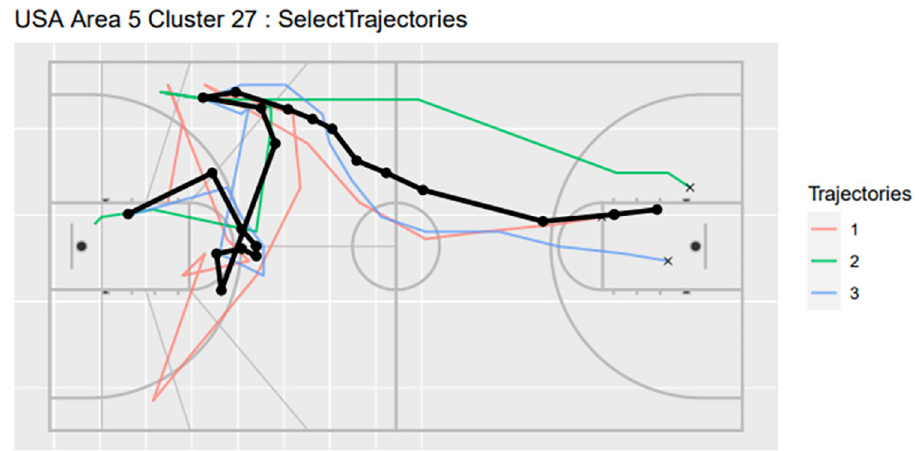
Fig 7. Trajectorial plots for USA Area 5 Cluster